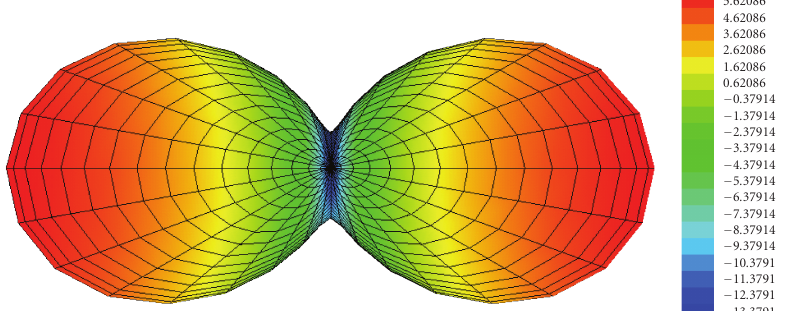
Figure 9: Dual radiating body radiation pattern.